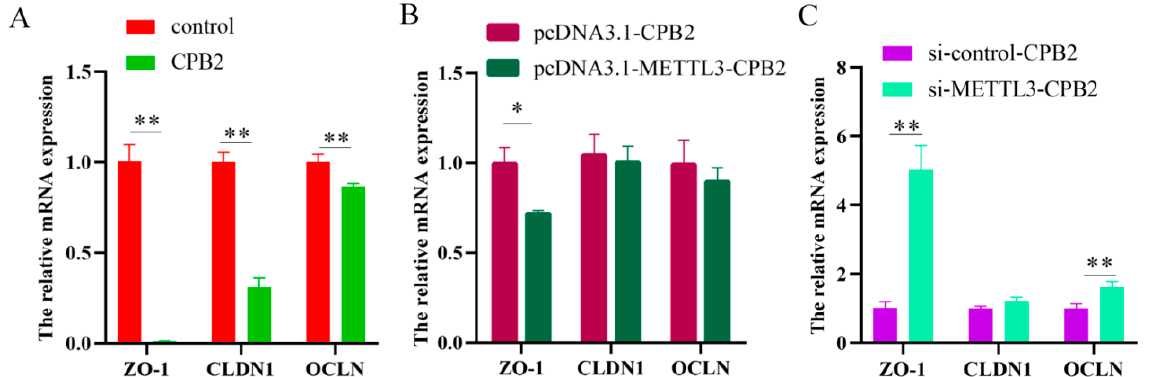
Figure 5. Tight junction protein mRNA expression. mRNA expression of tight junction protein ( ZO-1 , CLDN1 , OCLN ) in the control and CPB2 groups ( A ), pcDNA3.1-CPB2 and pcDNA3.1-METTL3-CPB2 groups ( B ), and si-control-CPB2 and si-METTL3-CPB2 groups ( C ). All data are based on three separate trials and presented as mean ± SD. ** p < 0.01 and * p < 0.05, re- spectively.